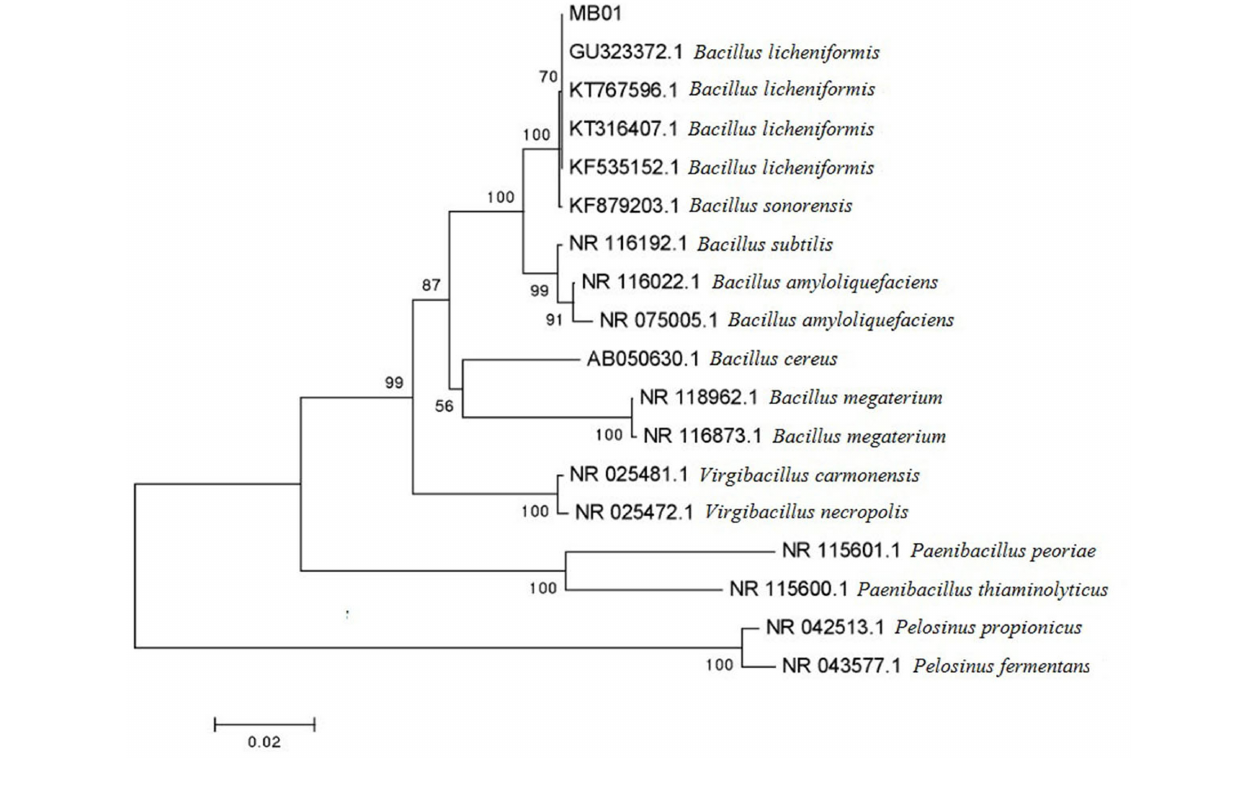
FIGURE 1 | Phylogenetic tree of